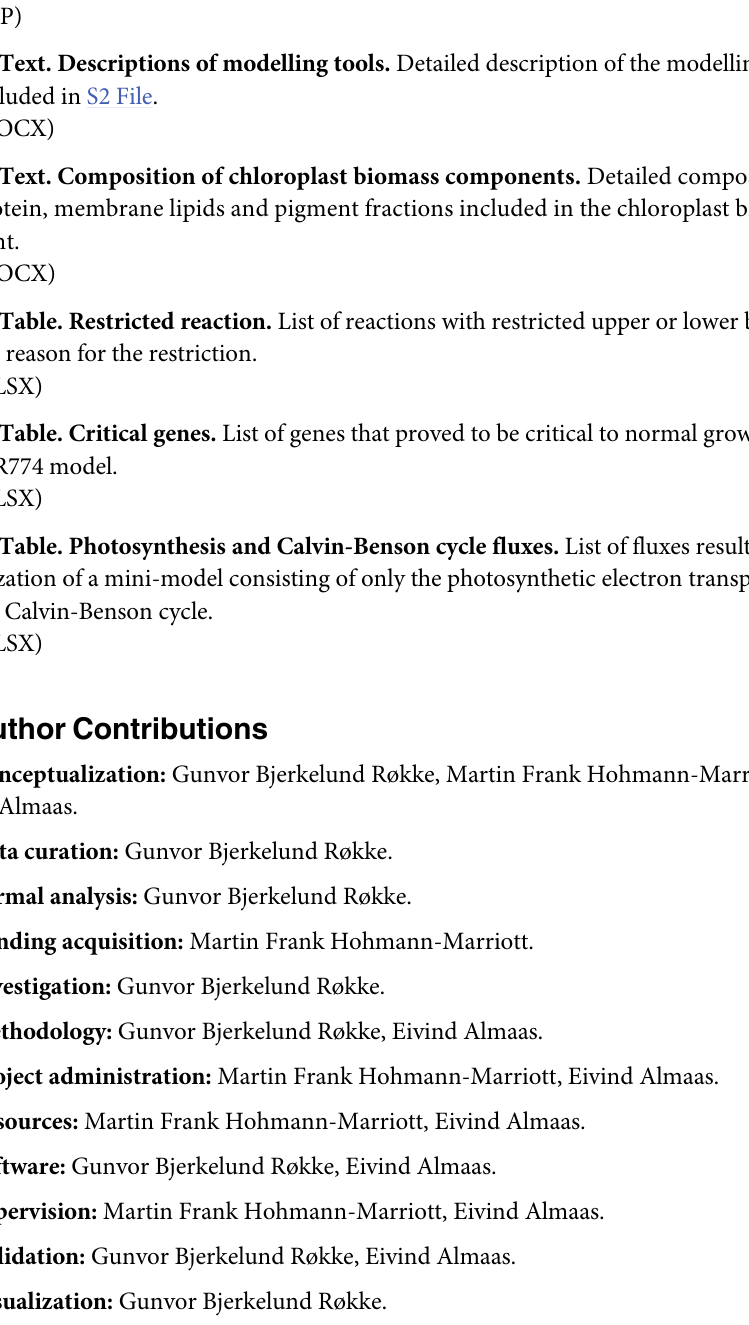
S1 Table. Restricted reaction. List of reactions with restricted upper or lower bounds, includ- ing reason for the restriction. S2 Table. Critical genes. List of genes that proved to be critical to normal growth of the iGR774 model. S3 Table. Photosynthesis and Calvin-Benson cycle fluxes. List of fluxes resulting from opti- mization of a mini-model consisting of only the photosynthetic electron transport chain and the Calvin-Benson